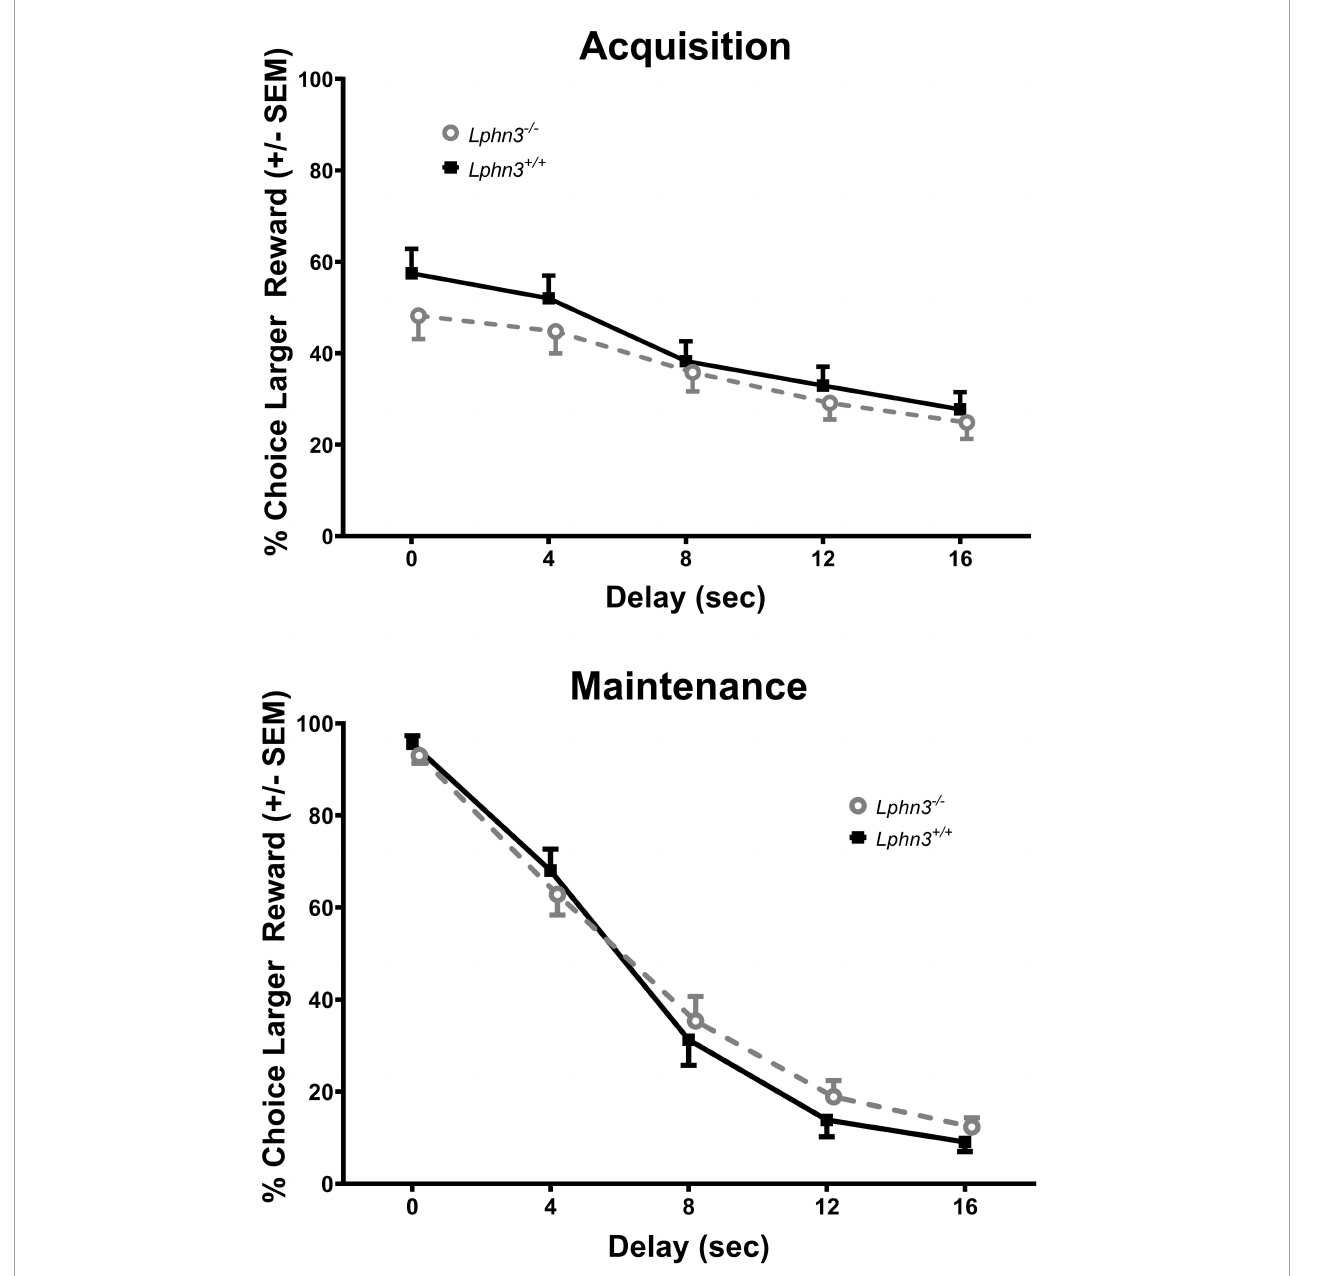
FIGURE3 Percent choice for the larger reward during acquisition (top) and maintenance responding (bottom) for the Lphn3 − / − (knockout) and Lphn3 + / + (wildtype) rats with equal trial lengths. Genotype had no effect of on delay-discounting (DD) performance.